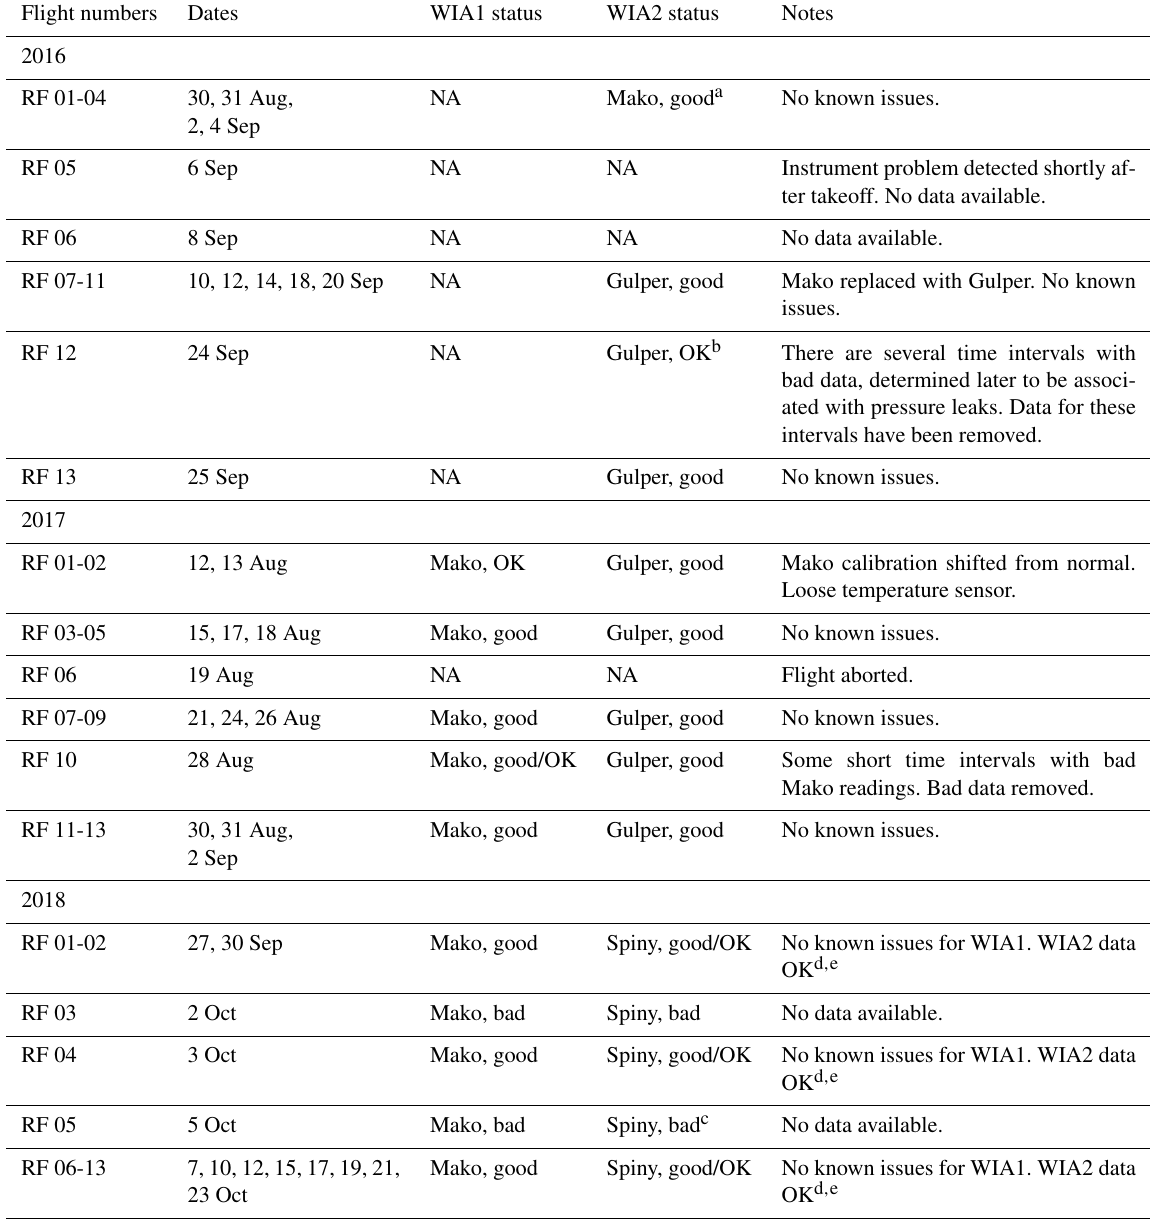
Table 1. WISPER status for all ORACLES